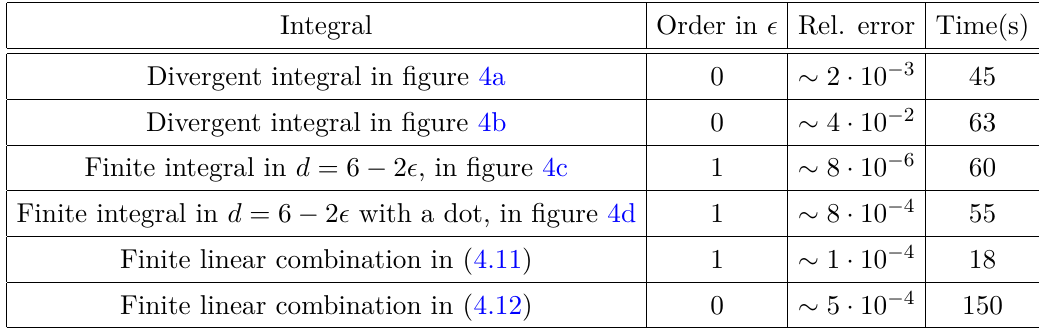
Table 2. Numerical performance of different non-planar integrals for a physical phase-space point. Timings generated with pySecDec [112] using the QMC algorithm [98, 113] on an Nvidia Tesla V100S GPU, with neval = 10 7